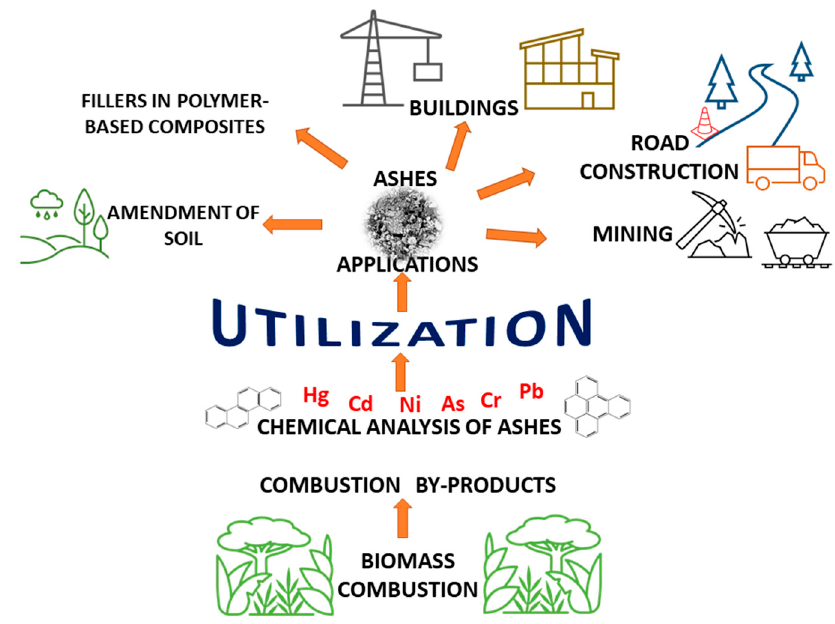
Figure 1. Utilization of biomass combustion ash.